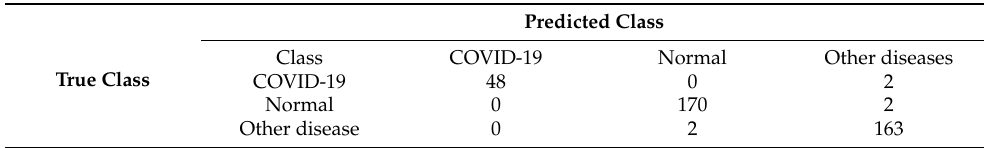
Table 9. Confusion matrix attained by ShuffleNet in three-class classification scheme using ECG images.